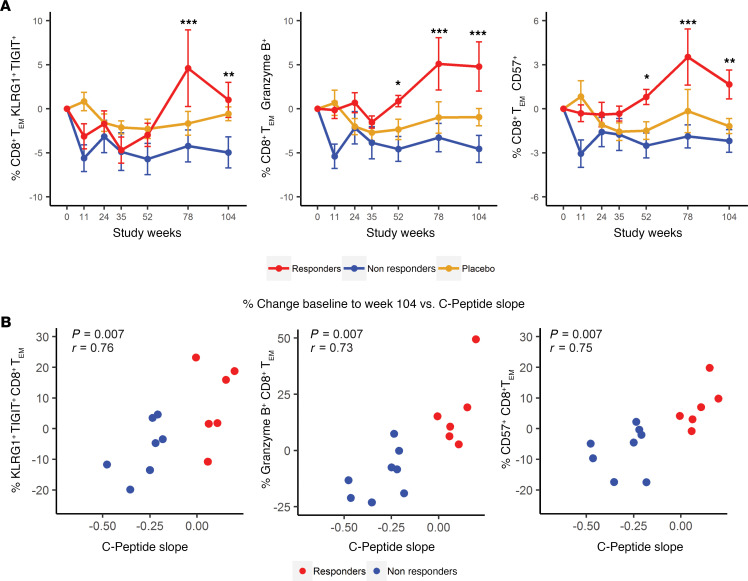
Increased frequency of memory CD8 subsets correlated with beneficial response to alefacept.(A) Longitudinal analysis of KLRG1+ΤIGIT+, Granzyme B+, and CD57+ is shown as the change from baseline percentage of CD8+ TEM in responders (n = 7; red), nonresponders (n = 9; blue), and placebo (n = 12; yellow). Differences between groups were analyzed by repeated-measures 1-way ANOVA with baseline adjustment and Bonferroni multiple comparison correction.*P < 0.05, **P < 0.01, ***P < 0.001. C1, cycle 1 of treatment; C2, cycle 2 of treatment. (B) Plots show correlation of the C-peptide change with the change of %KLRG1+TIGIT+, Granzyme B+, and CD57+ CD8+ TEM from baseline to week 104 in responders (n = 6) and nonresponders (n = 7). Spearman correlation were performed with FDR adjustment for multiple comparison.